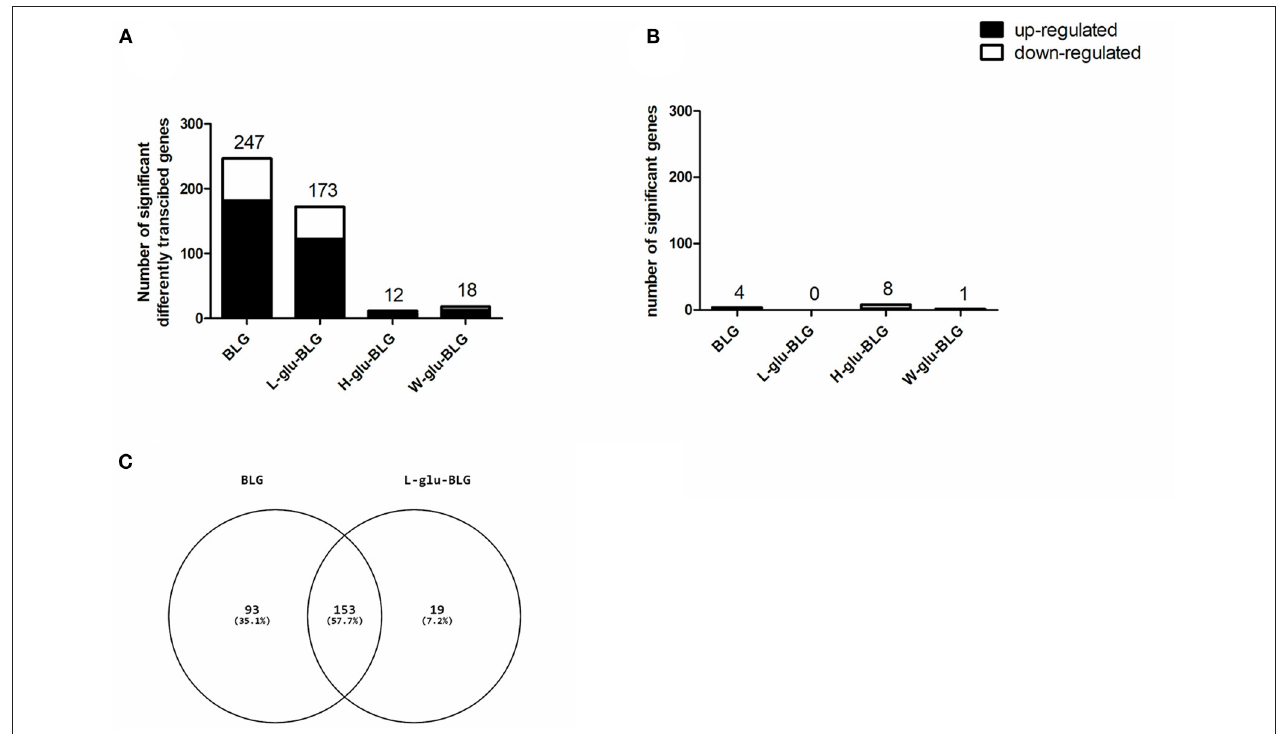
FIGURE 7 | After exposure to BLG samples, THP-1 derived dendritic-like cells (iDC) hardly showed a response in gene transcription profiles if compared to medium control, while the response of macrophage-like cells (M0) mainly occurred in response to native and L-glu-BLG. THP-1 monocytes were differentiated into M0 and iDCs and incubated with medium (non-treated) or different BLG samples (native, L-glu-BLG, H-glu-BLG, or W-glu-BLG) for 6h. Microarray analysis provided data on the transcriptome which was expressed as average fold change between treated vs. non-treated cells of 3 independent experimental replicates. The bar chart indicates the number of significantly (with fold change absolute value > 2 and q value < 0.05) up or down regulated genes for M0 (A) and iDC (B) treated with native or processed BLG. In a Venn diagram the numbers of significantly transcribed genes which are shared or exclusive for M0 incubated with BLG or L-glu-BLG were shown (C)